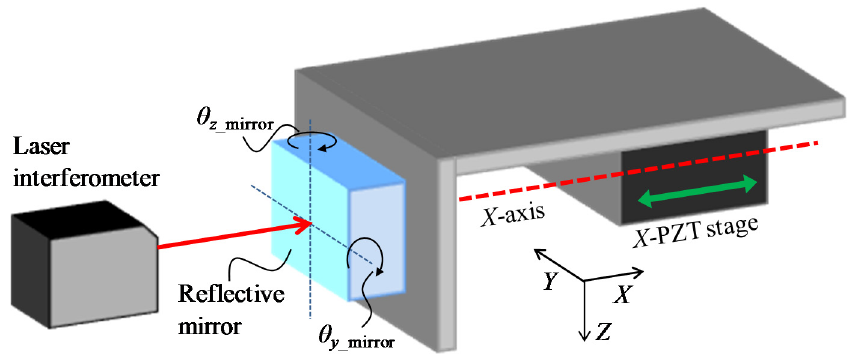
Figure 7. Tilt errors of the reflective mirror with respect to the optical axis of the laser interferometer.